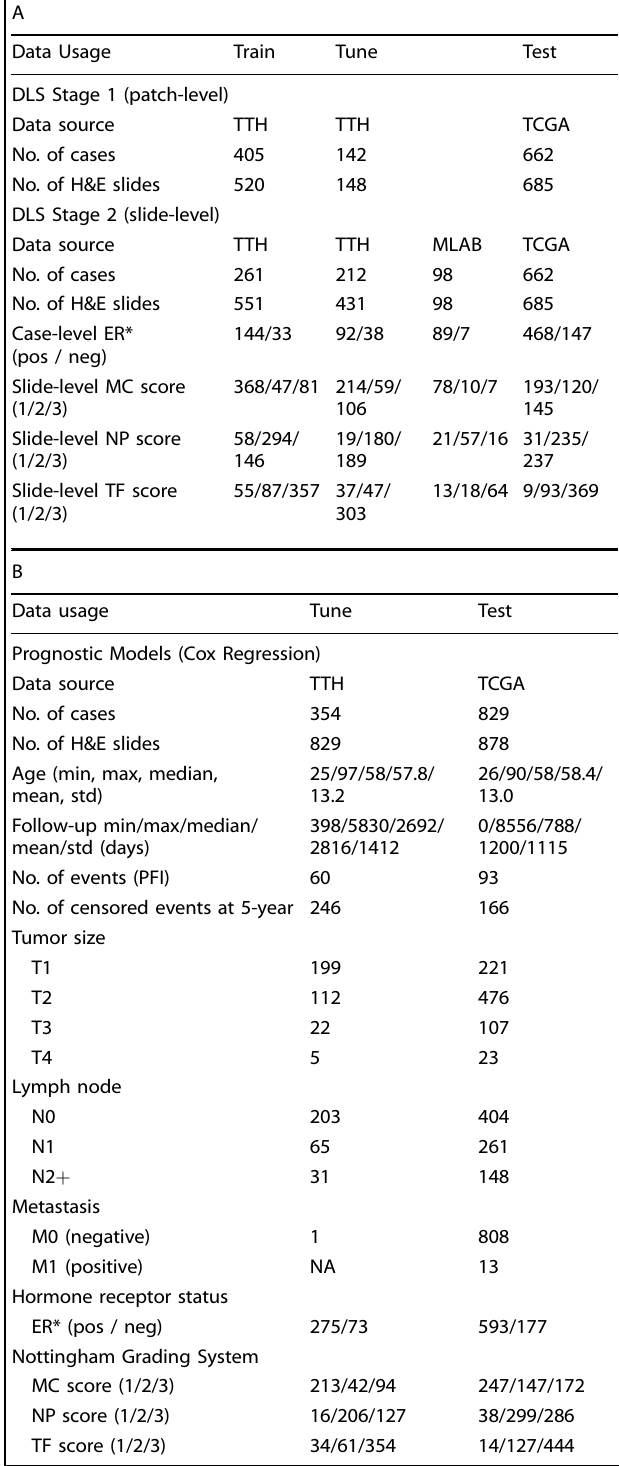
Table 1. Dataset characteristics for development and evaluation of grading and outcome prediction